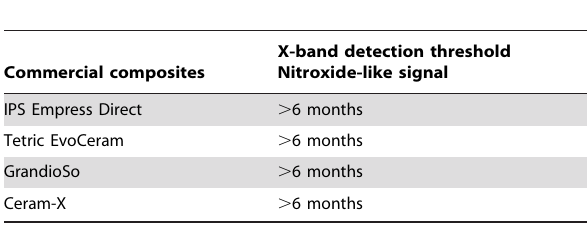
Table 9. Detection limit of composites showing the atypical nitroxide-like